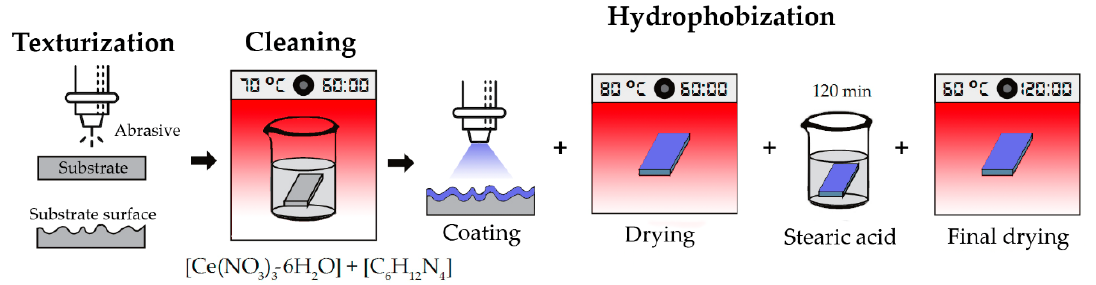
Figure 2. Scheme for the deposition of cerium-based coatings by immersion using cerium nitrate.